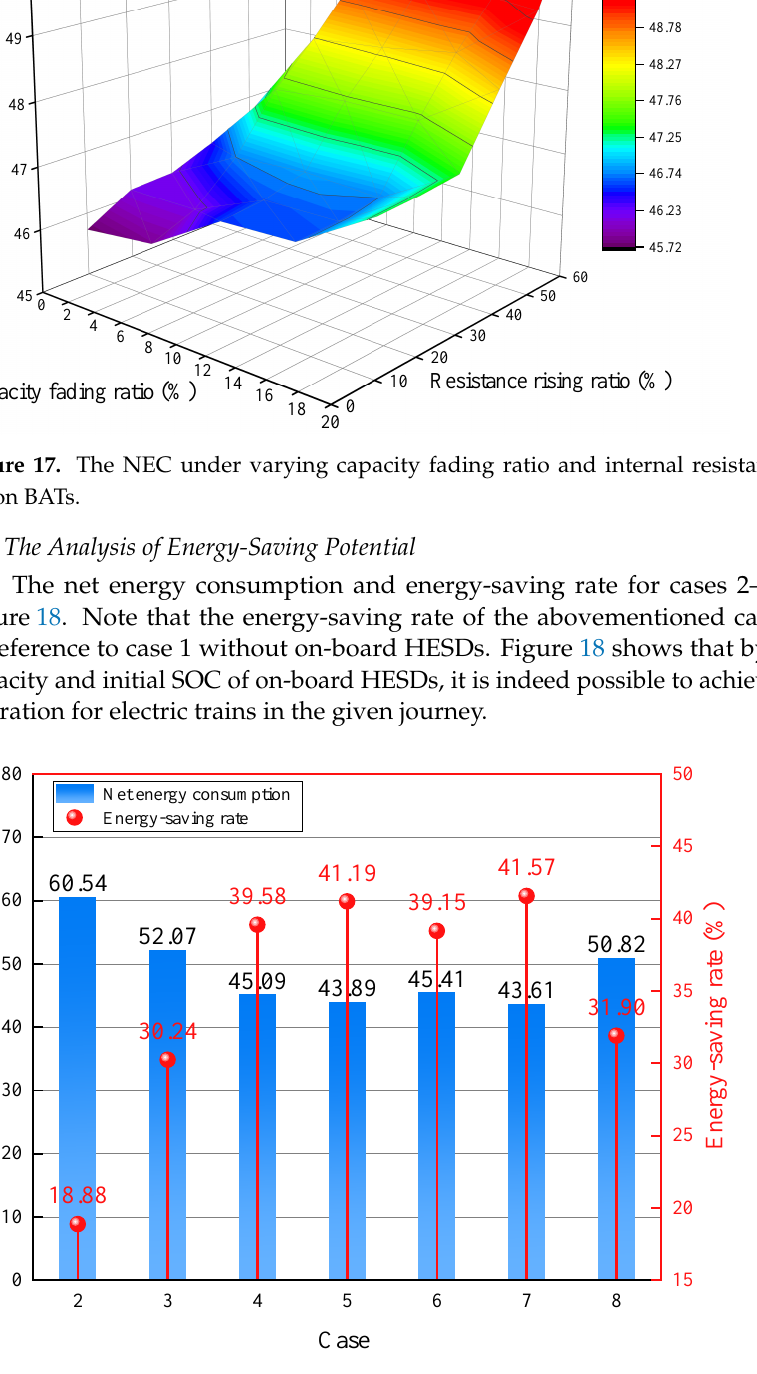
Figure 18. The net energy consumption and energy-saving rate for cases